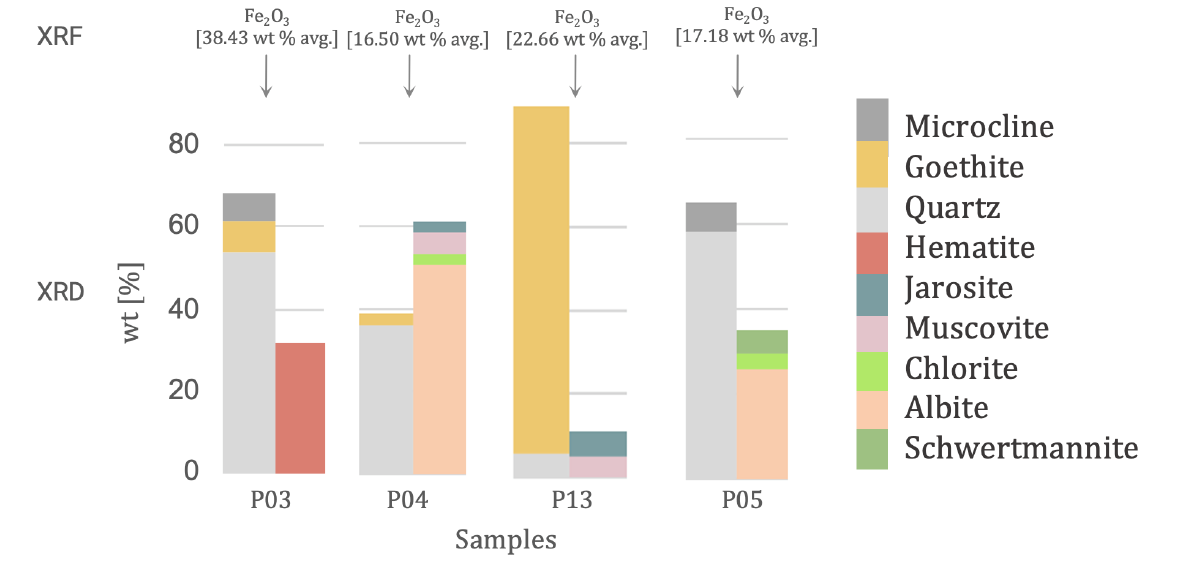
Figure 11. Chart of the main mineral fractions of four selected samples determined by the XRD mineralogical analyses. Results of the iron-fraction after XRF analysis are